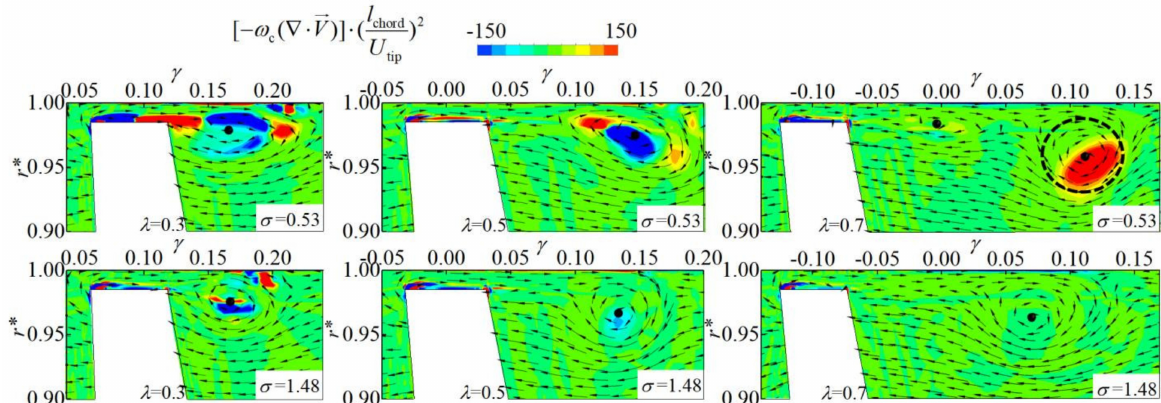
Figure 21. Comparison of the vortex dilation term distributions on the three planes for the cavitating case ( upper ) and non-cavitating case ( lower ).